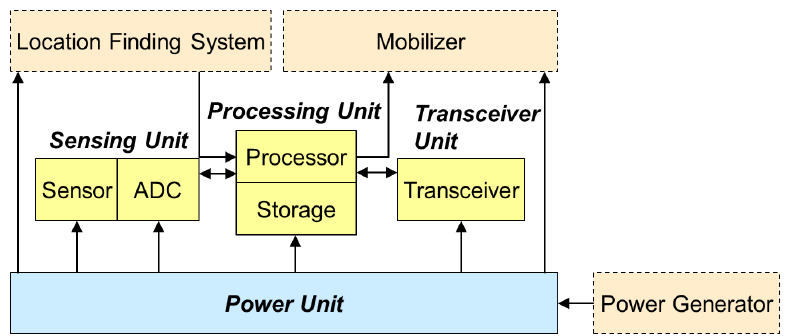
Figure 1. The components of a sensor